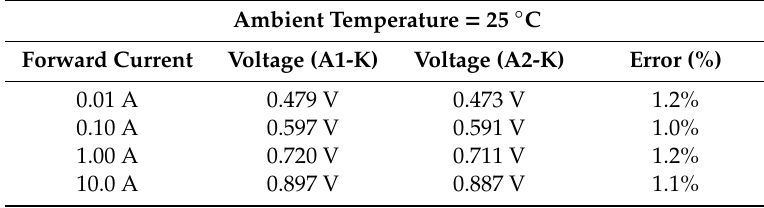
Figure 2. ( a ) Schematic internal structure of a twin diode, ( b ) diagrams showing thermal profiles of a twin diode (10 mA), ( c ) of a twin diode (1 A) and ( d ) of a twin diode (10 A). Table 1. Uniformity of current-voltage characteristics of twin diodes at 25 ◦